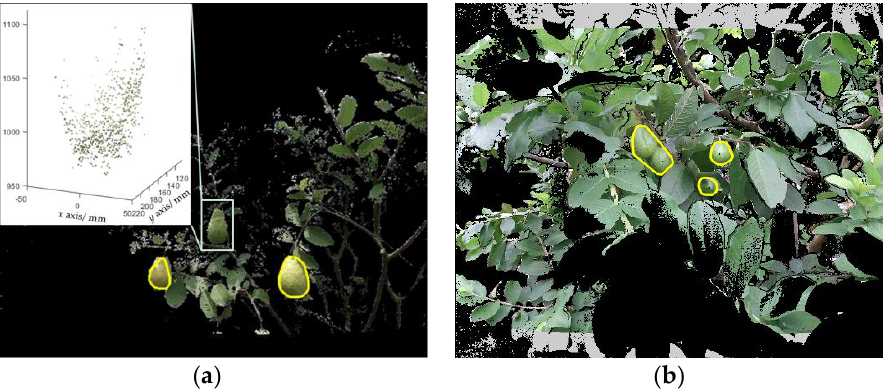
Figure 9. Examples illustrating unsuccessful detections.